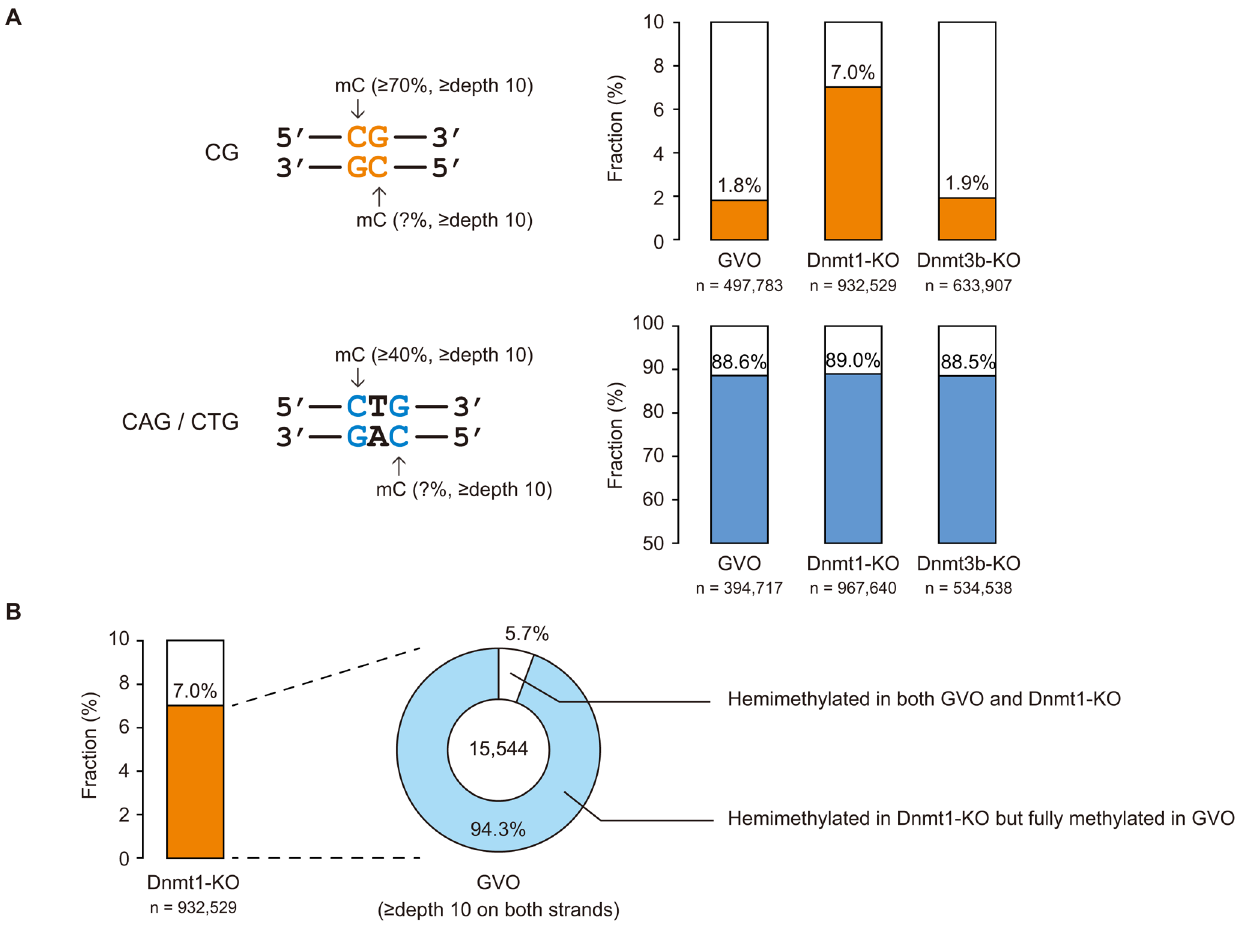
Figure 3. Strand asymmetry in methylation at CG and non-CG sites. (A) Fractions of CG and CAG/CTG sites showing strand asymmetry in methylation (hemimethylation) in GVOs, Dnmt1-KO, and Dnmt3b-KO. The data were taken from CG and CAG/CTG sites with methylation levels of $ 70% and $ 40%, respectively, on at least one strand, with a read depth of at least 10 6 for both strands (left). Bar charts show the hemimethylated fractions (right). Statistical differences in methylation between the strands were calculated using Fisher’s exact test (p , 0.05). Note that most CAG/ CTG sites are hemimethylated in all samples and that CG sites show increased hemimethylation in Dnmt1-KO. (B) CG sites hemimethylated in Dnmt1- KO but not in GVOs. Dnmt1-KO demonstrated an increase in hemimethylated CG sites (orange, left), most of which were fully methylated in GVOs.